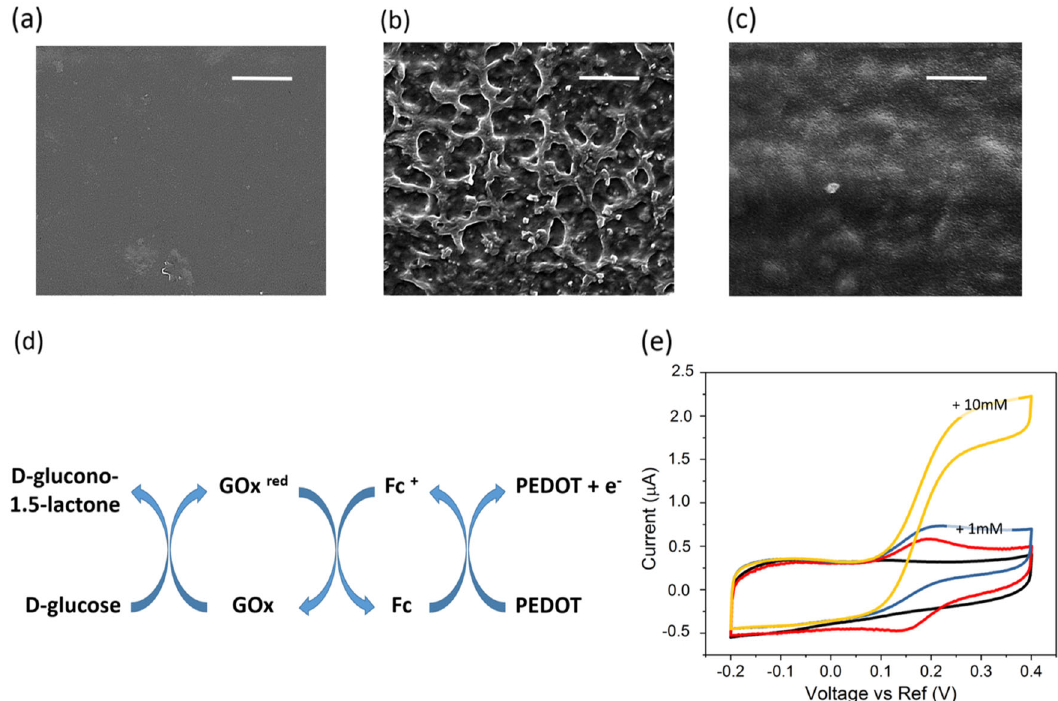
Fig. 2 SEM images of PEDOT:PSS fi lm printed on paper a , covered with 6 printed layers of the biological ink b , and 2 layers of na fi on c . The scale bar is 1 µm. d Mechanism of the enzymatic reaction. Upon reaction with glucose, the reduced enzyme is re-oxidized via Fc + /Fc couple. The electron mediator then transfers one electron to PEDOT:PSS. e Cyclic voltammetry (CV) curves of the biosensor comprising 6 printed layers of the biological layer measured in PBS (red lines) and in the presence of glucose (1 mM and 10 mM, blue and yellow lines, respectively). The black line is the CV curve of PEDOT:PSS before the deposition of the biological layer. The scan rate is 20 mV/s. The device was not coated with na fi Spectroscopy (XPS) C 1s spectra show characteristics peaks representative of each layer: for instance, C – O for PEDOT:PSS, C = O for the biological ink (chitosan) and C-F for na fi on (Figure S1a). The peaks located in N 1s region only appear after the biological layer is printed (Figure S1b). S 2p spectrum undergoes changes upon na fi on addition due to the SO 3 bonds (Figure S1c), con fi rming the layer-by-layer integration of each component on top of PEDOT:PSS. The mechanism of glucose detection based on the enzyme/ mediator complex involves a cycle of electrochemical reactions at the surface of the working electrode as depicted Fig. 2d. Upon reacting with glucose, GOx gets reduced. The reduced enzyme cycles back via the ferrocene/ferricenium (Fc/Fc + ) ion couple which mediates electron transfer from the active sites of GOx to the underlying PEDOT:PSS electrode. This reaction causes a change in the current fl owing between the working and counter electrodes, proportional to the concentration of glucose. Figure 2e shows the cyclic voltammetry (CV) curves of the PEDOT:PSS electrode, before and after its modi fi cation with the Fc/GOx fi lm as well as in the presence of glucose in the electrolyte. The electrolyte, phosphate buffered saline solution (PBS, pH 7.4), is placed on top of the active area of the sensor. The well ‐ de fi ned and symmetric peaks at ca. 0.2 V and ca. 0.15 V (anodic and cathodic, respectively) of the biofunctionalized PEDOT:PSS are characteristic of Fc (compare black and red lines in Fig. 2e). The biological ink here was printed as 6 successive layers and we observed a direct correlation between the number of printed layers with the amplitude of Fc peaks (Figure S2a). Upon addition of glucose into the PBS solution, we observe a drastic increase in the anodic current, evidencing effective immobilization of GOx, its reaction with glucose and communication with Fc and PEDOT:PSS (Fig. 2e, S2b). The current increases further with more glucose